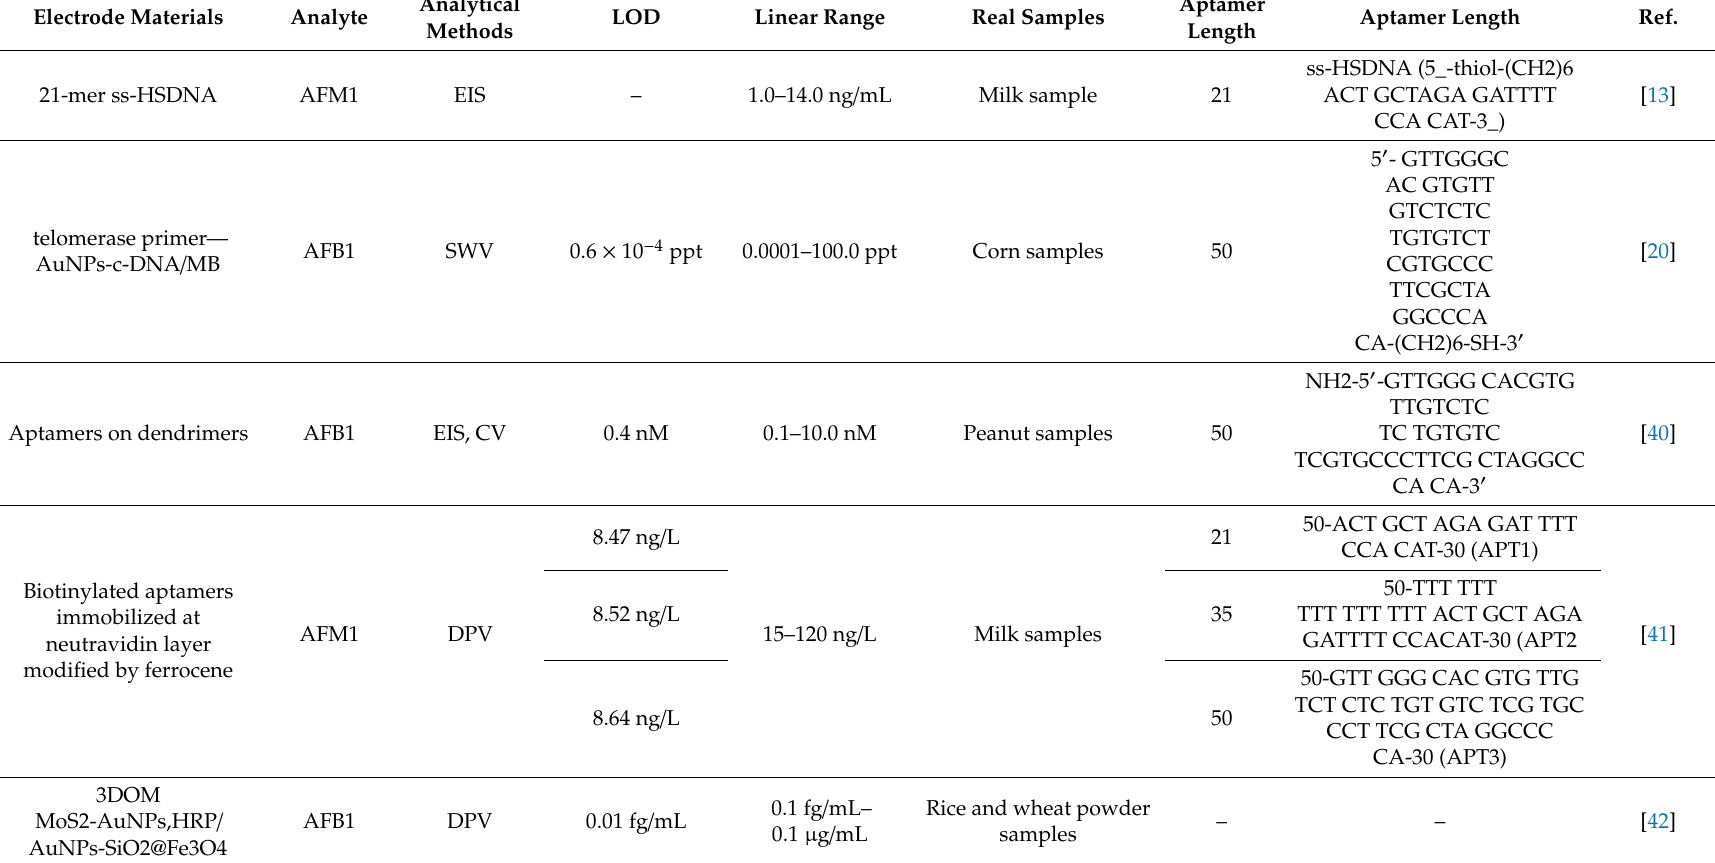
Table 3. Comparison of the e ffi ciency of gold electrode-based aptasensors to detect